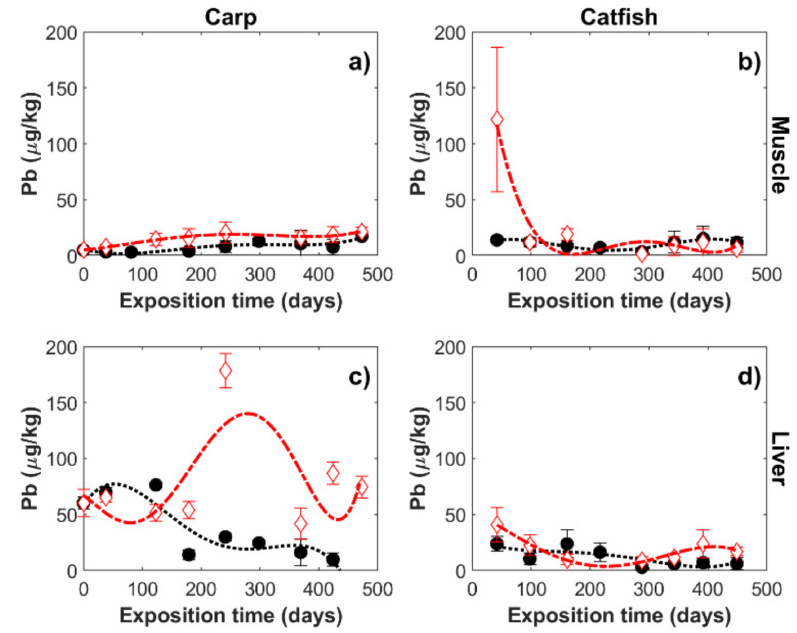
Figure 5. Pb accumulation in the experimental ( • ) and control groups ( carp, ( b ) muscle in catfish, ( c ) liver in carp, and ( d ) liver in